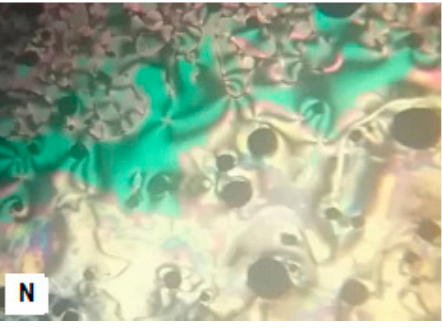
Figure 1. DSC thermograms of ( a ) I 6 and ( b ) I 8 observed from second heating/cooling at a rate of ±10 ° C.